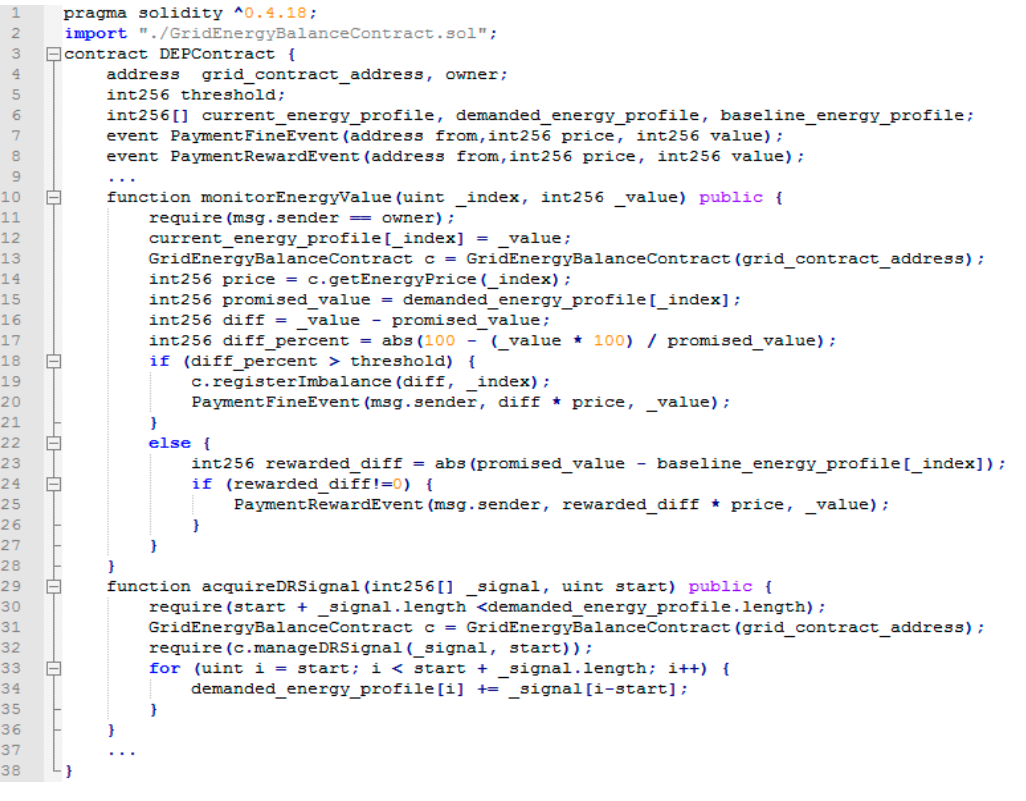
Figure 8. Smart grid energy unbalanced state before blockchain based optimization and planned DR signal.